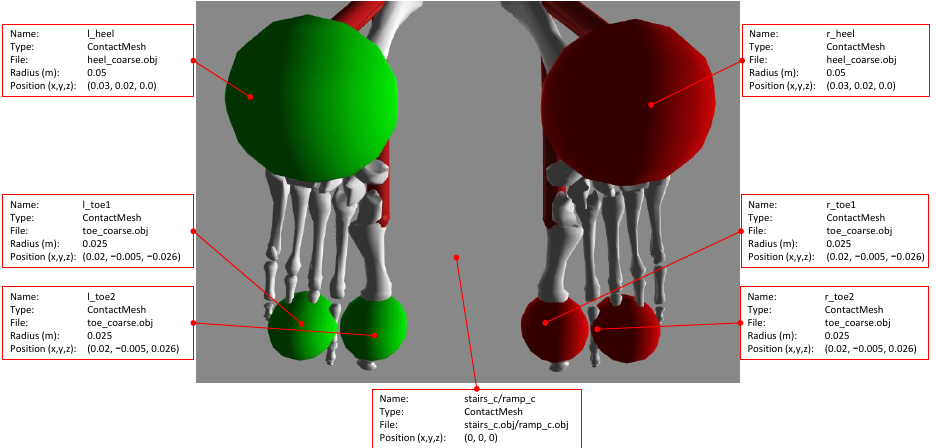
Figure 3. Bottom view of the spherical contact meshes for the heels and toes with respect to the bones in the feet (left foot in green, right foot in red, and feet bones in